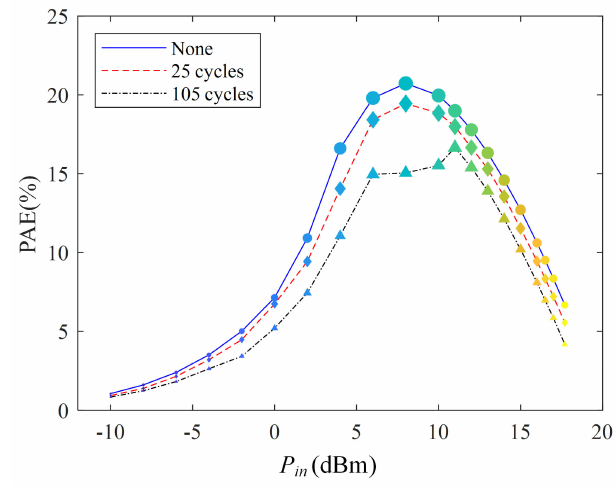
Figure 7. PAE of PA under thermal shock